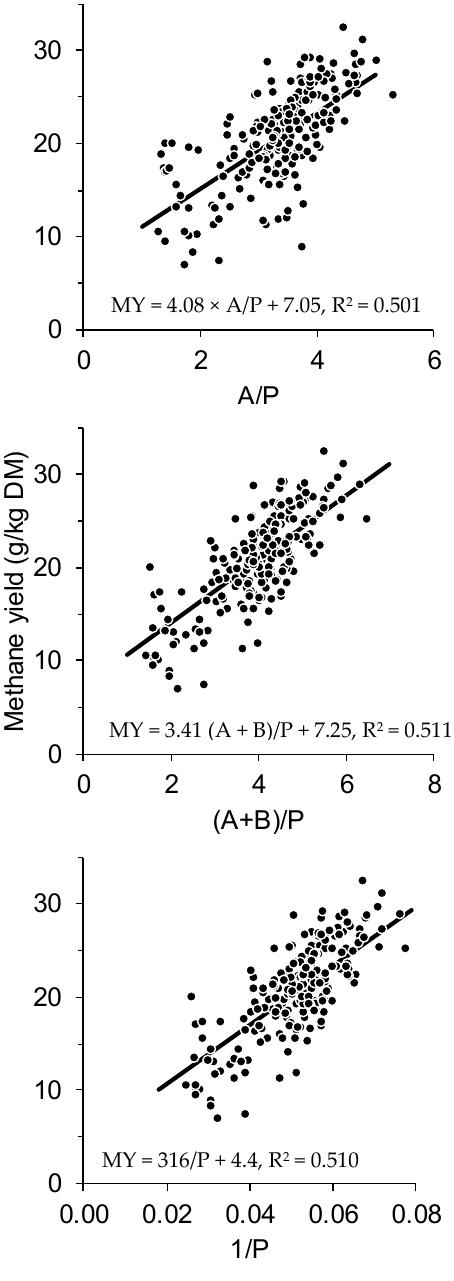
Figure 2. Combined methane yield (MY, g / kg DM) data from seven previously conducted experiments [24–30] plotted against ruminal fatty acid ratio A / P, (A + B) / P, and 1 / P, with linear equations fitted by linear mixed e ff ects meta-analysis (solid